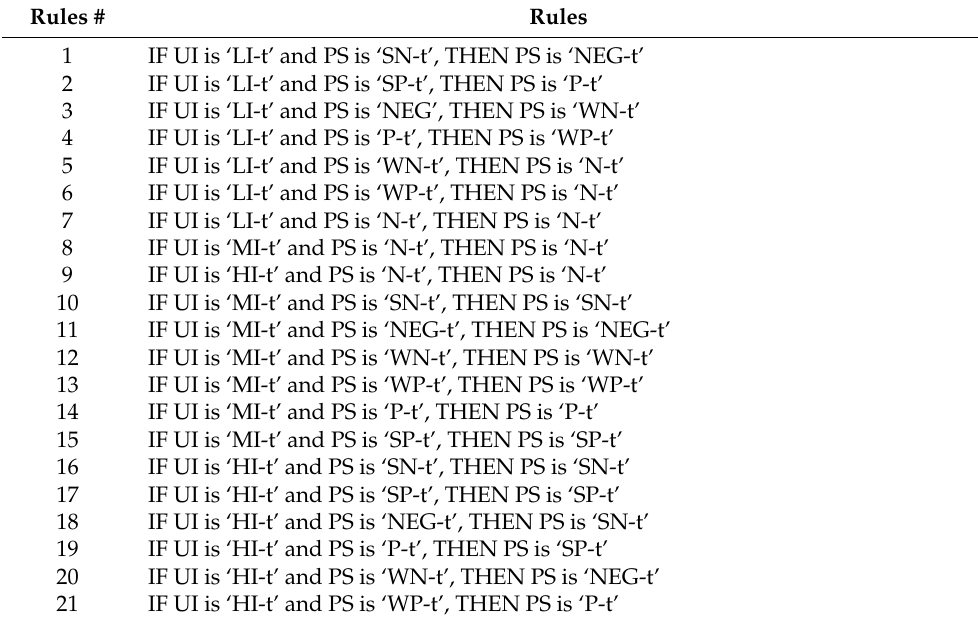
Table 1. Sample of the designed NL rules.